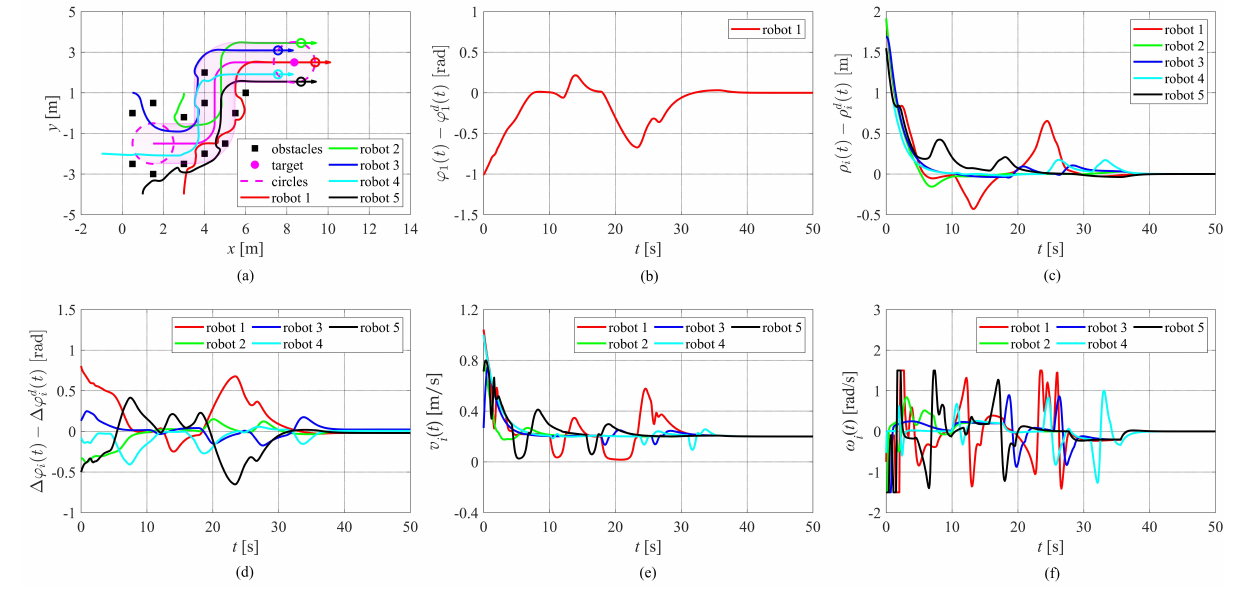
Figure 4. Simulation results of case 2. ( a ) Trajectories of five robots and a moving target with a constant speed in a plane. ( b ) Error between current phase and the desired phase of robot 1. ( c ) Distance errors between five robots and their desired circles centered on the target. ( d ) Errors between current angular spacing and the desired angular spacing of all adjacent inter-robots. ( e ) The linear speeds of five robots. ( f ) The angular speeds of five robots.